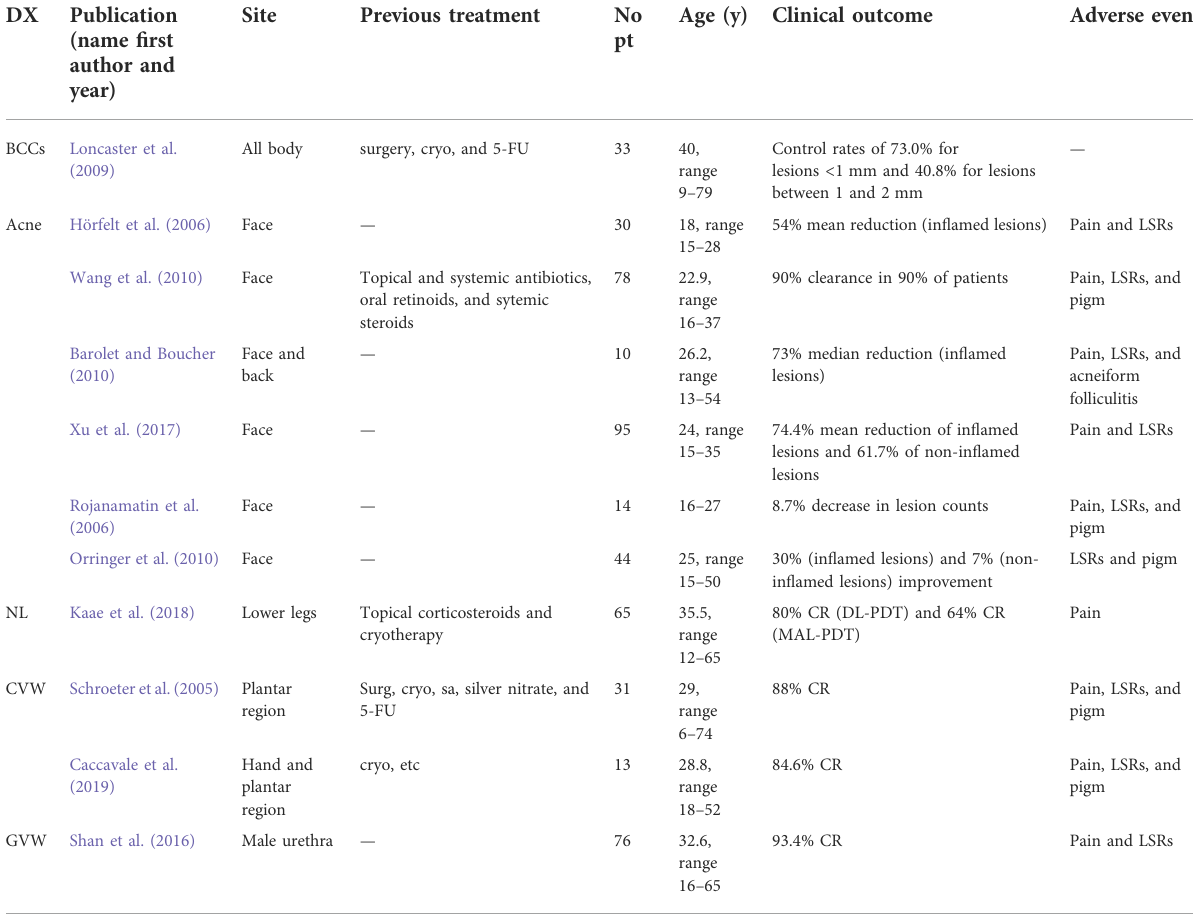
TABLE 3 Studies including both adults and children with no speci fi c data on pediatric patients. Patients ’ age, clinical features, and PDT clinical